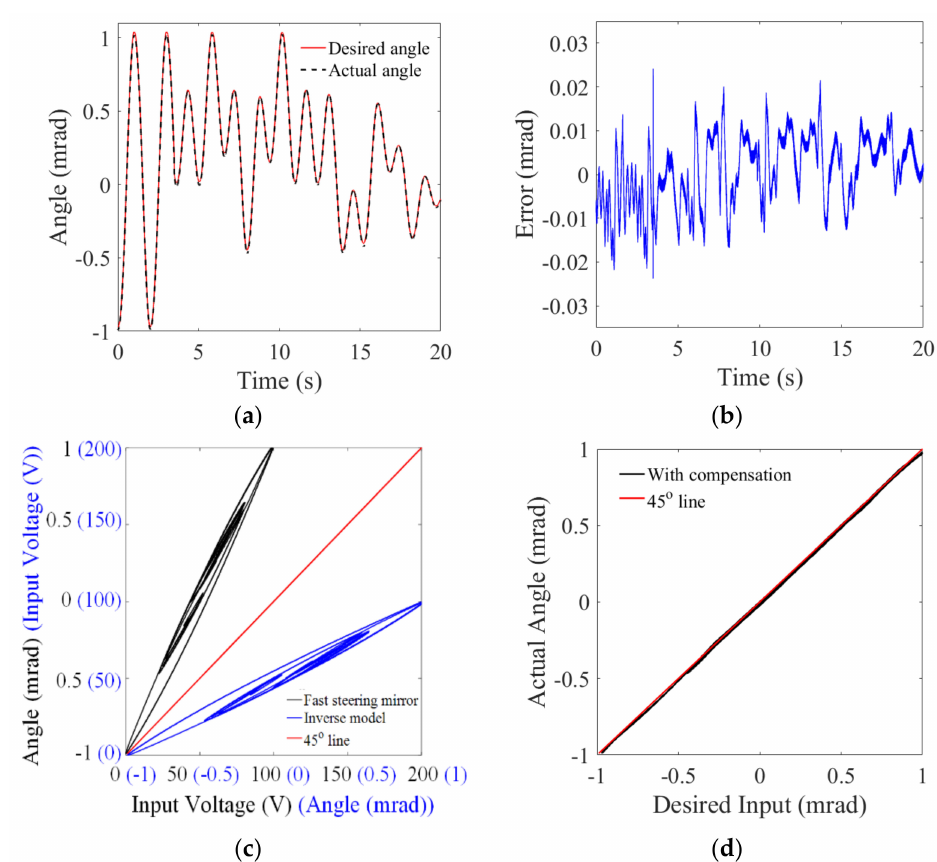
Figure 16. Compensation results. ( a ) Desired and actual angle signals. ( b ) Error. ( c ) Symmetrical relationship between the actual hysteresis and the inverse hysteresis model. ( d ) Actual angle versus input